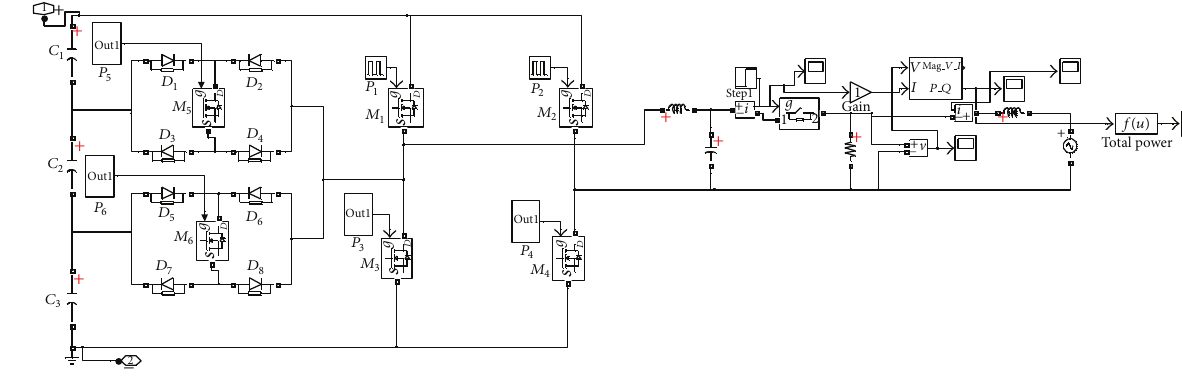
Figure 14: Simulated model for seven-level inverter.